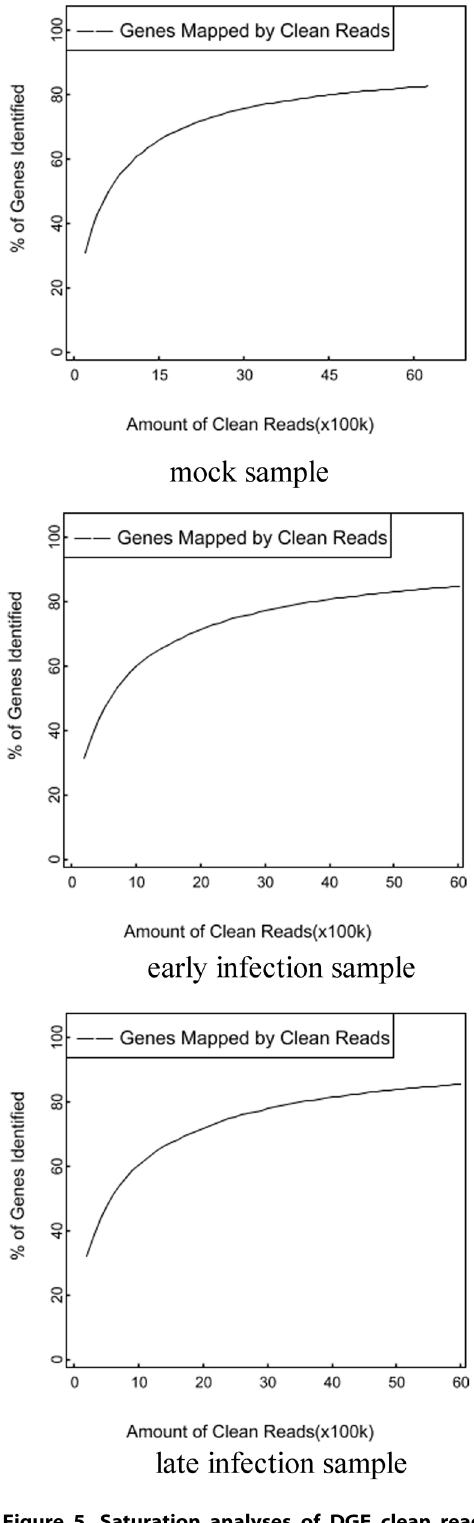
Figure 5. Saturation analyses of DGE clean reads generated from mock, early infection and late infection samples. With the number of reads increasing, the number of detected genes is increasing. When the number of reads reaches certain value, the growth rate of detected genes flattens, and it means that the number of detected genes tends to